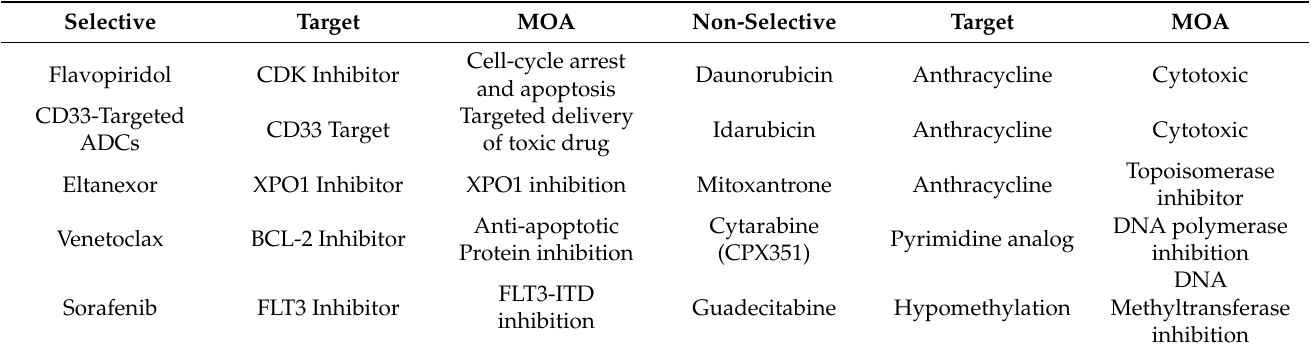
Table 1. Target and mechanism of action (MOA) of some of the selective and non-selective drugs used in the treatment of acute myeloid leukemia (AML) .